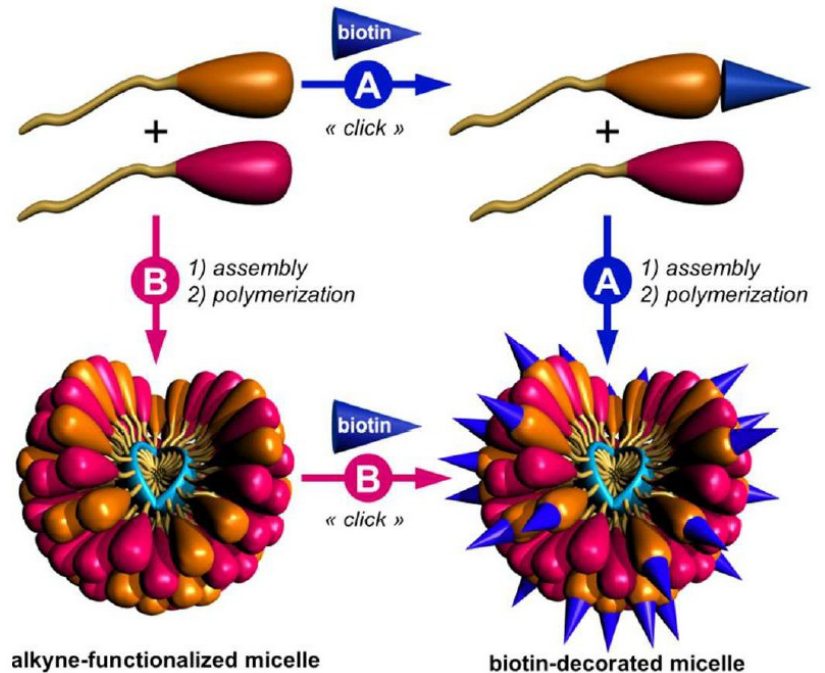
Figure 4. Schematic presentation of the two biotinylation strategies. With permission from [112]